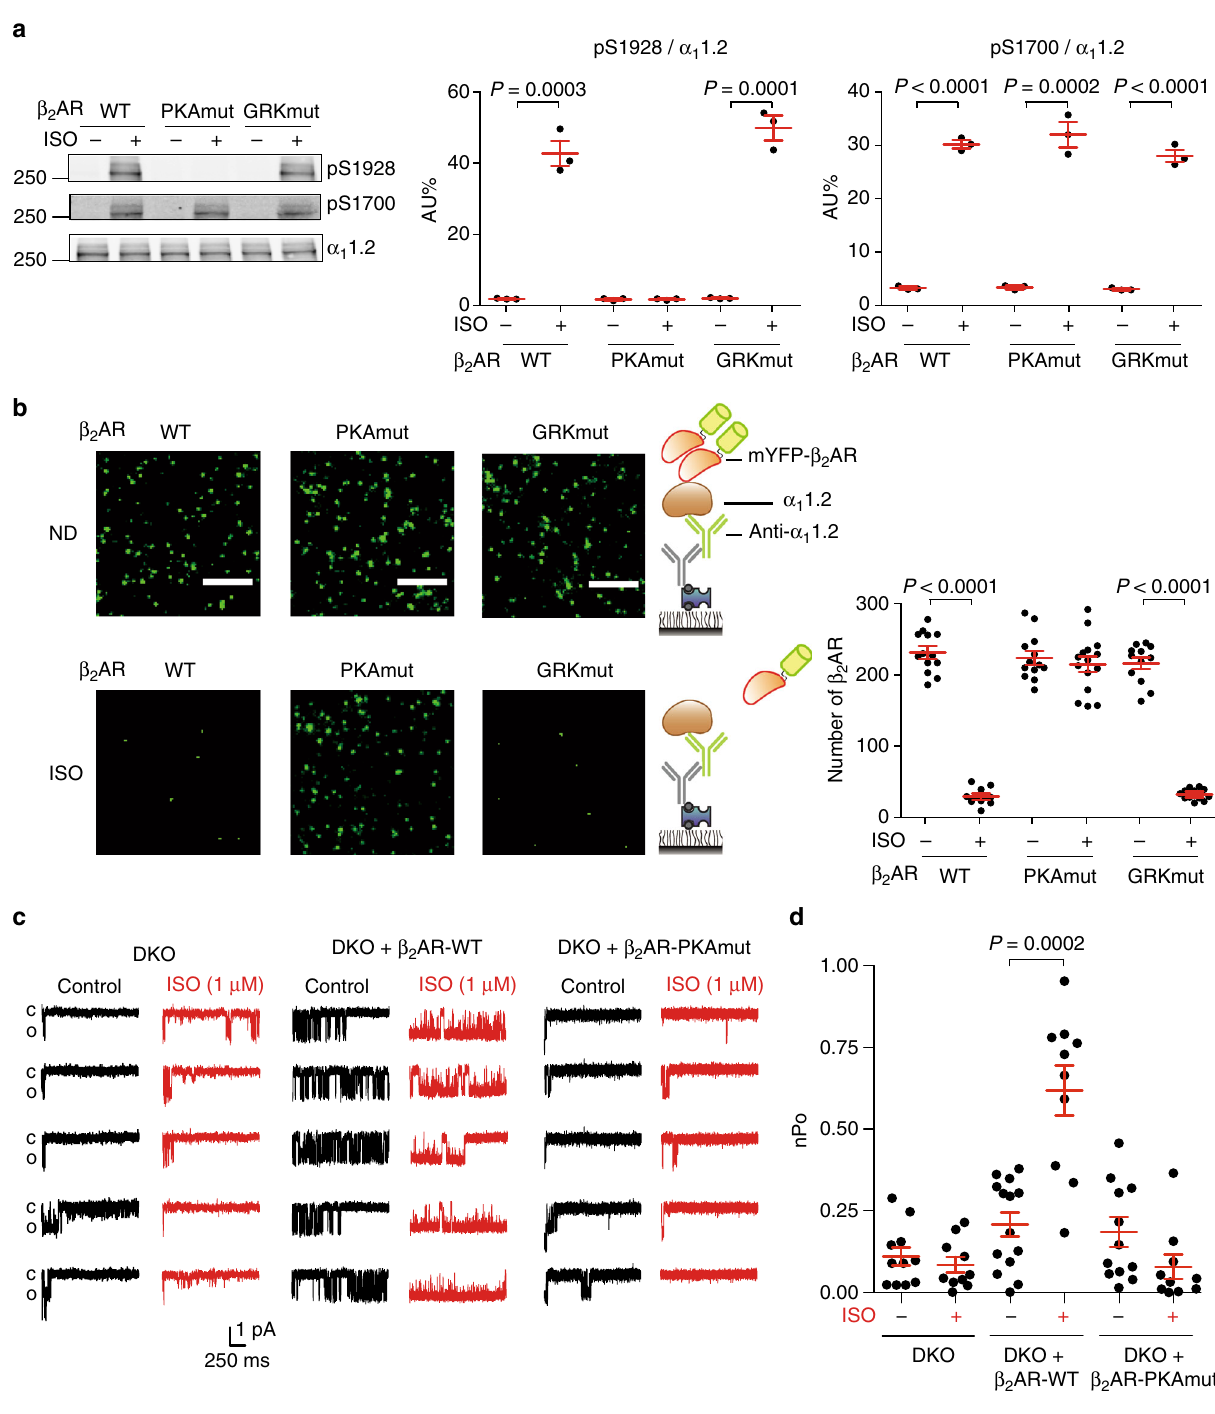
Fig. 7 PKA-p β 2 AR is necessary for activation of β 2 AR- α 1 1.2 complex in hippocampal neurons. WT or mutant β 2 AR lacking either PKA sites (PKAmut) or GRK sites (GRKmut) was expressed in hippocampal neurons lacking both β 1 AR and β 2 AR genes (DKO). a Neurons were either not stimulated (ND) or stimulated with 1 μ M ISO for 5 min. The total α 1 1.2 was immunoprecipitated; the phosphorylation of α 1 1.2 at S1928 and S1700 was probed with phospho- speci fi c antibodies and normalized to total α 1 1.2. Representative of three independent experiments. Molecular weight markers (in kDa) are indicated on the left. b The endogenous α 1 1.2 was pulled down in SiMPull as depicted; representative images show that mYFP- β 2 AR pulled down together with α 1 1.2. Scale bar, 5 μ m. Quanti fi cation of the numbers of mYFP- β 2 AR bound to α 1 1.2 shows that PKA-phosphorylation of β 2 AR is required for dissociation of the β 2 AR- α hippocampal neurons at 7 – 14 DIV expressing WT and mutant β 2 AR were subjected to single-channel recording of LTCC currents using the same method as Fig. 6. d The overall channel activity (nPo) of LTCC Ca v 1.2 was quanti fi ed from c ( n = 11, 10, 14, 10, 12, and 10 cells, respectively). Error bars denote s.e. m., exact P values are computed by Student ’ s t -test in a and b , and by Mann – Whitney test in